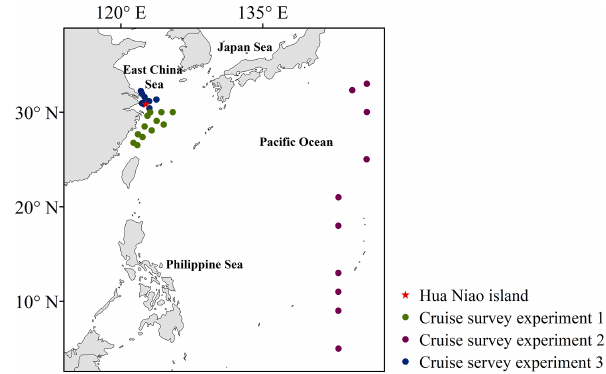
Figure 4. Locations of atmospheric DMS observations from cruise survey experiments 1–3, and the MSA observation site on Hua Niao